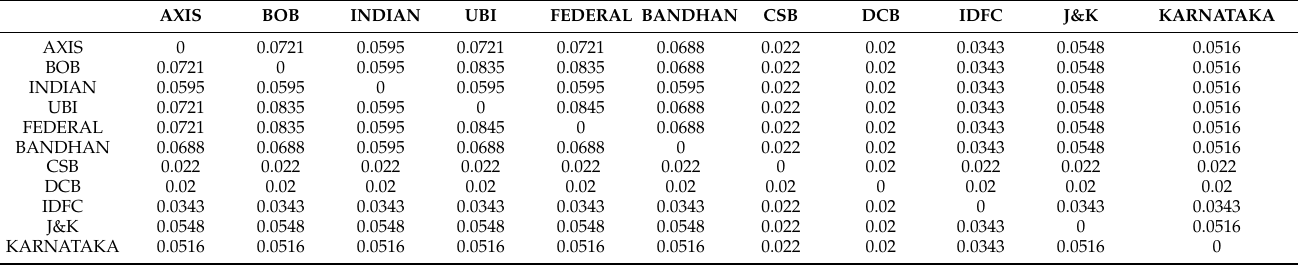
Table 10. Adjacency matrix of the strength of connectedness (1st component) reduced list of 11 banks.